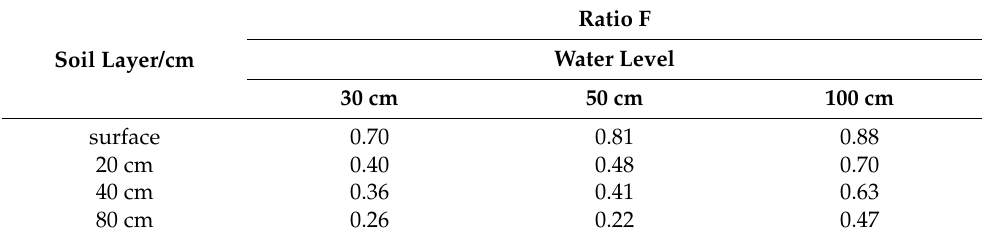
Table 8. The ratio of nitrate and ammonia nitrogen average contents in the same soil